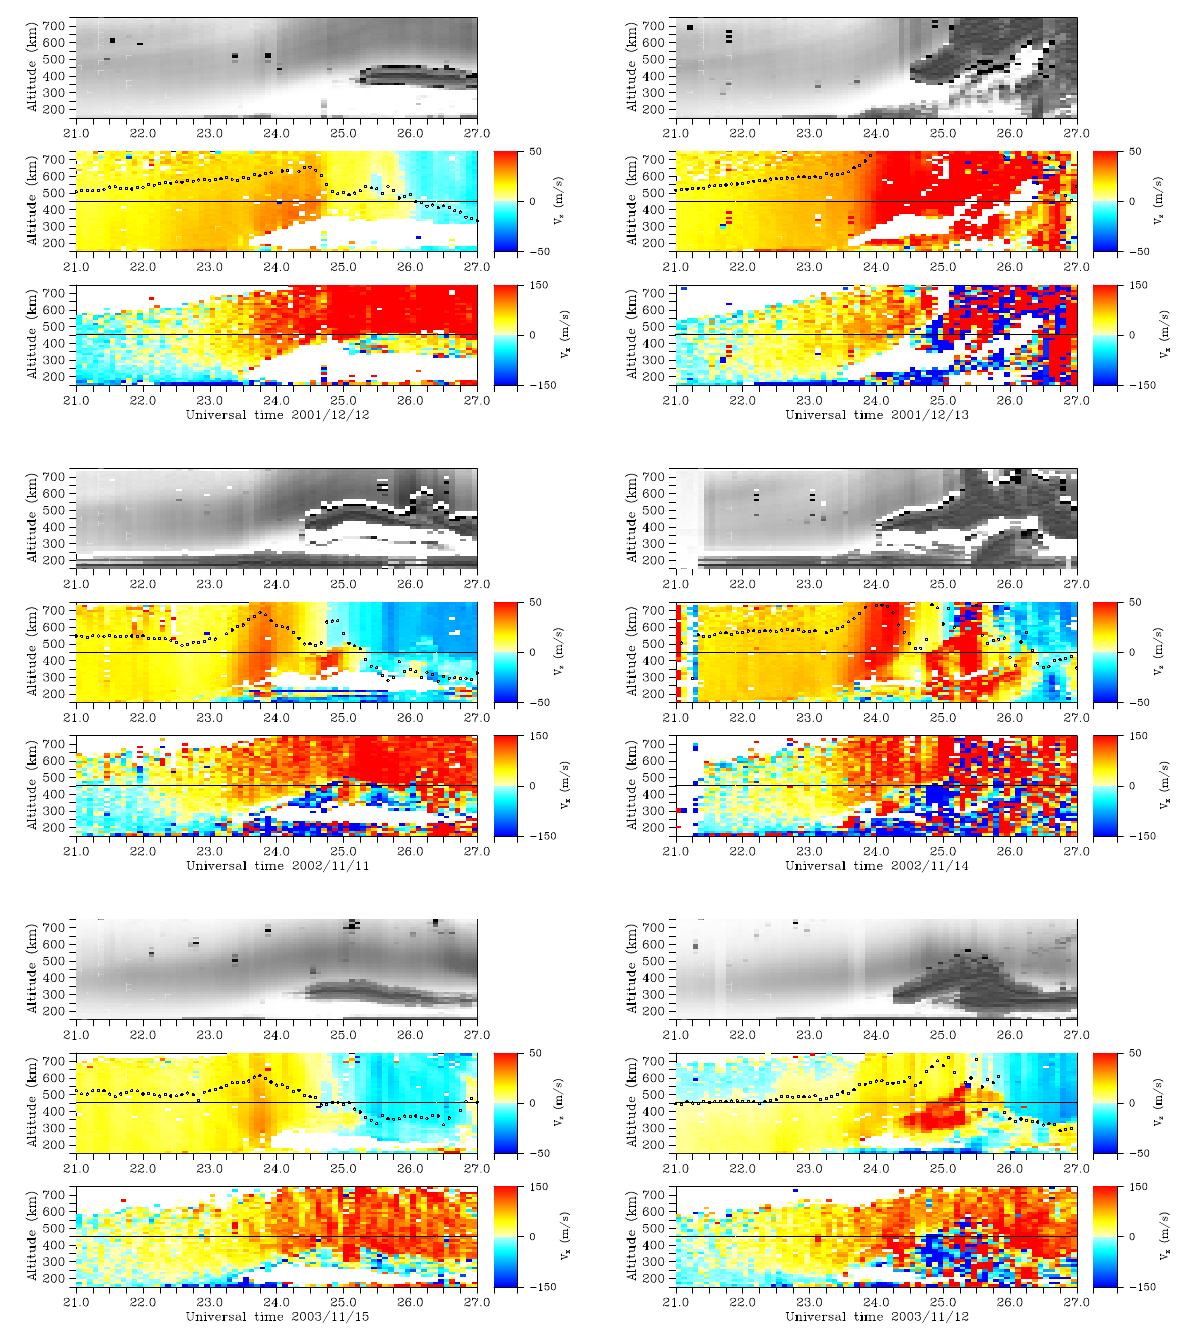
Fig. 1. Six examples of ionospheric conditions around twilight. Each example shows the backscatter power (top panel), vertical plasma drift (middle panel), and zonal plasma drift (lower panel), plotted against the scales shown. Symbols plotted in the middle panel represent the vertical drift velocity at 450km altitude for reference. The left and right columns portray events when topside spread F did not and did occur, respectively. Note that